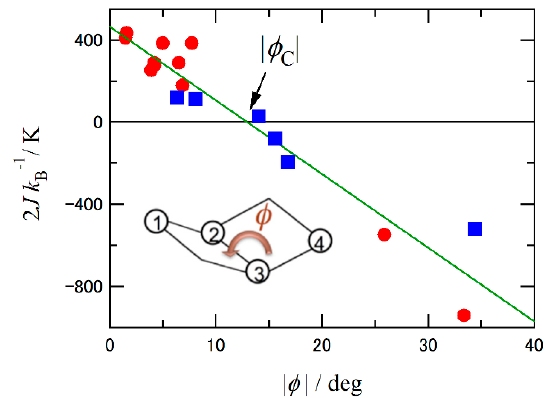
Figure 4. A plot of the exchange coupling parameter (2 J ) vs. | ϕ (M–O–N–C sp2 )| in the octahedral nickel(II) and copper(II) complexes with nitroxide (red circles) and nitronyl nitroxide ligands (blue squares) (NO and NN, respectively, in Figure 2). The source of these data has appeared in Refer- ences [74,88–90]. A solid line stands for a linear fit. Inset shows a schematic drawing of ϕ defined in the atomic sequence 1-2-3-4.